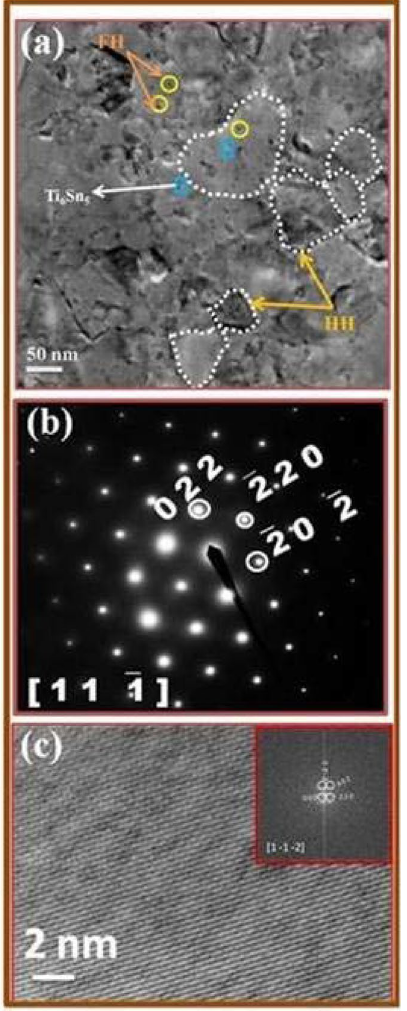
Fig. 1 a Low-magnification TEM micrograph of the Ti (Nano-BNC) displaying two phase contrasts of HH phase (marked as dotted white lines) and FH inclusions (marked as yellow-colored circle) along with the trace amount of Ti 6 Sn 5 phase (marked as blue- color rectangle); b selected area electron diffraction pattern (SAED) obtained from the dotted white lines showing the HH phase along the [1 1 – 1] zone axis; c HRTEM image obtained along (220) plane of FH phase revealing a lattice scale image. The fast Fourier transform (FFT) taken from this lattice scale image as shown in the inset con- firms the black contrast to be FH